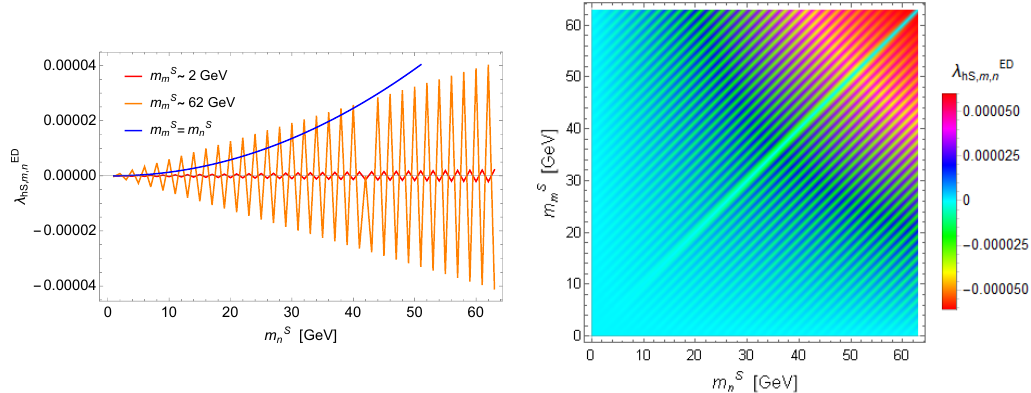
Figure 9 . Left: the coupling (cid:21) ED (cid:21) hS = 1. Right: coupling (cid:21) ED